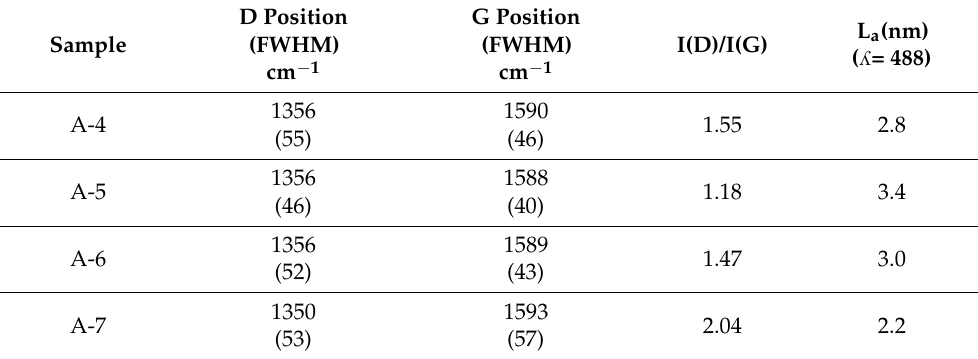
Figure 5. 13 C MAS NMR spectra of ceramic SiC/C f microspheres obtained by ceramization of polysiloxane microspheres at 1600 °C for 5 h under argon; DVB/PHMS w / w ratio 0.97 (A-6).